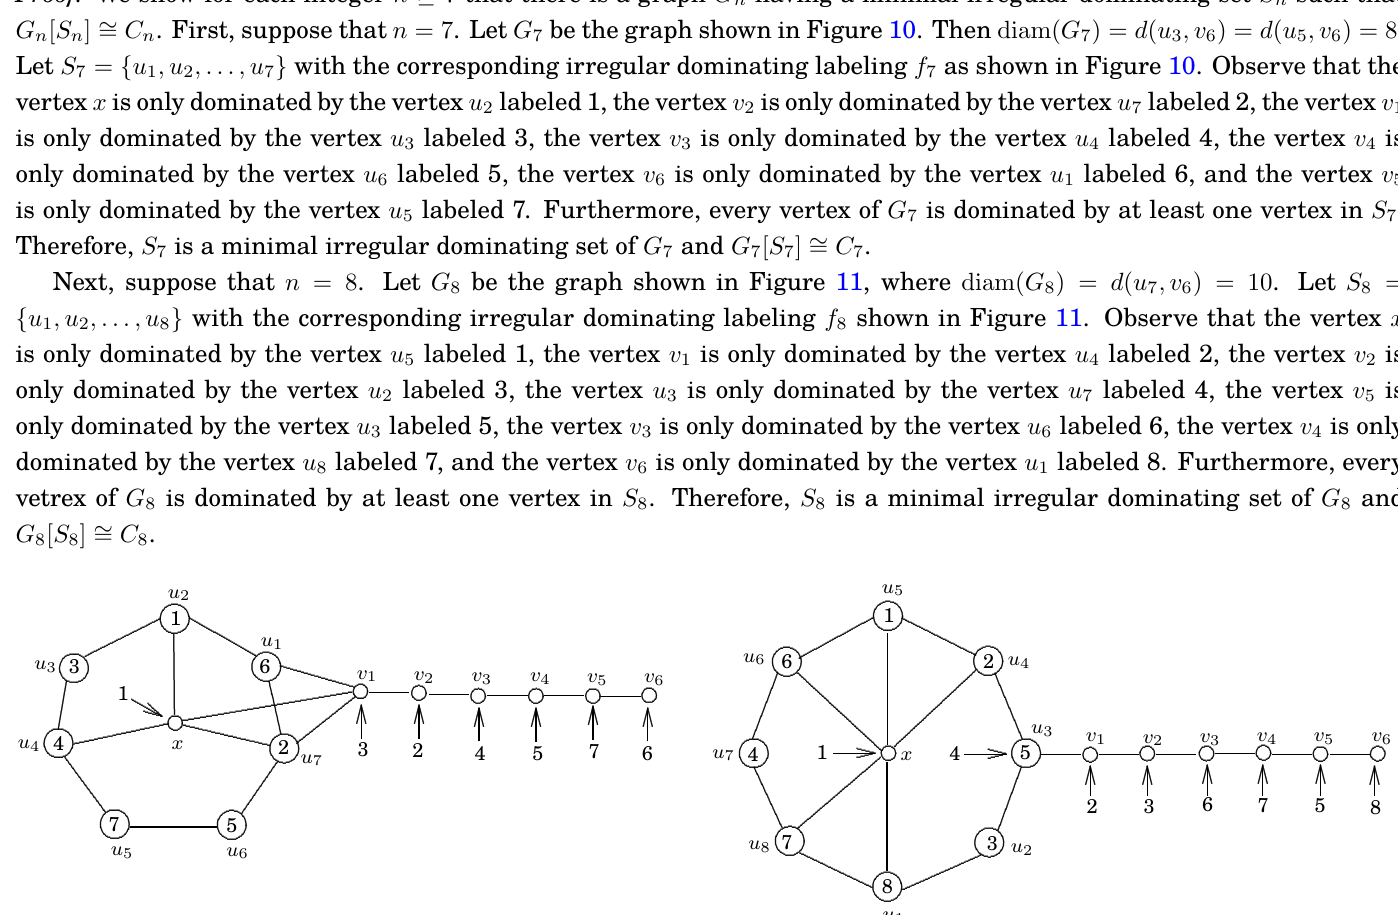
Figure 10: Showing that C is an irregular domination 7 graph. Figure 11: Showing that C